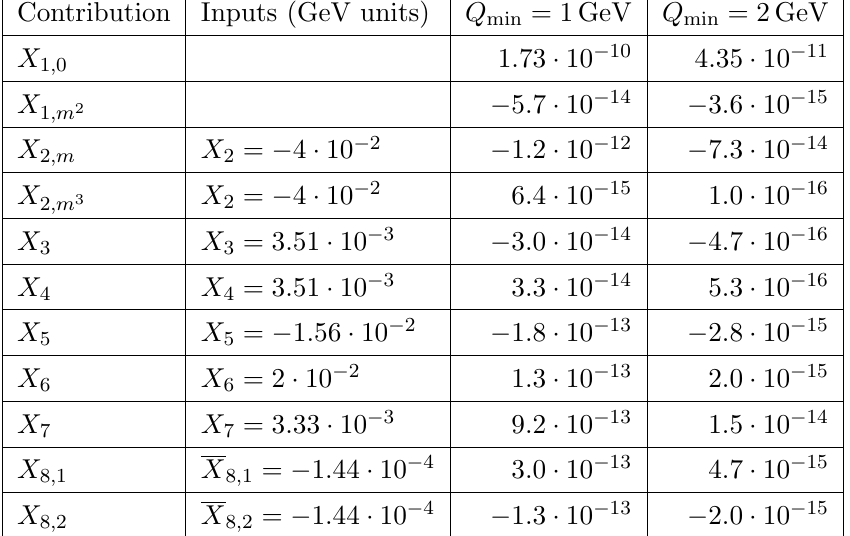
for the indicated inputs. (cid:22)